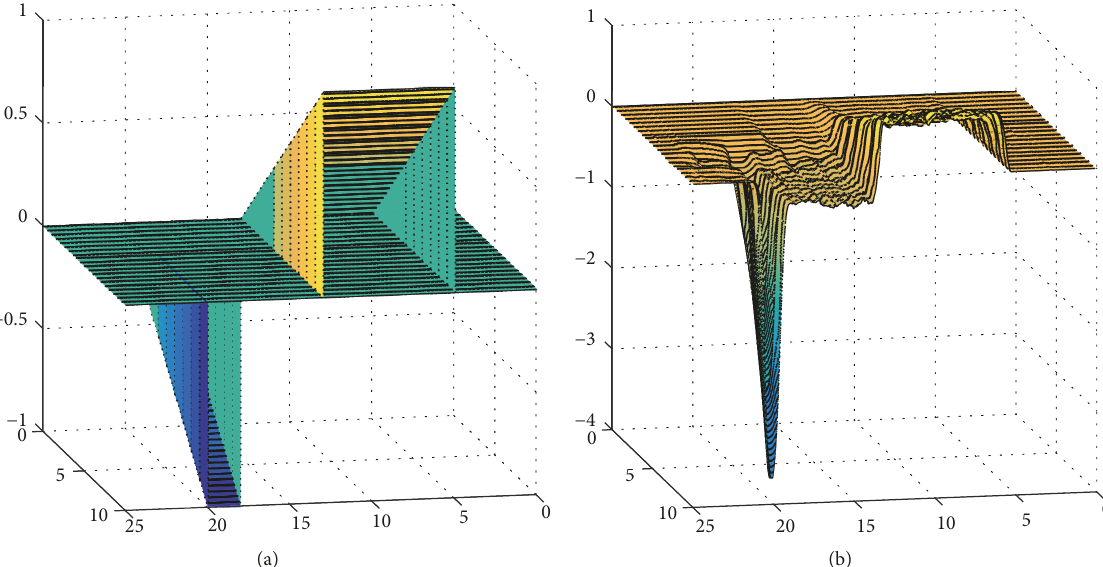
Figure 4: (a) Signal control references from on-board computer to longitudinal control actuators and (b) longitudinal acceleration in real test platform in 10 different tests.